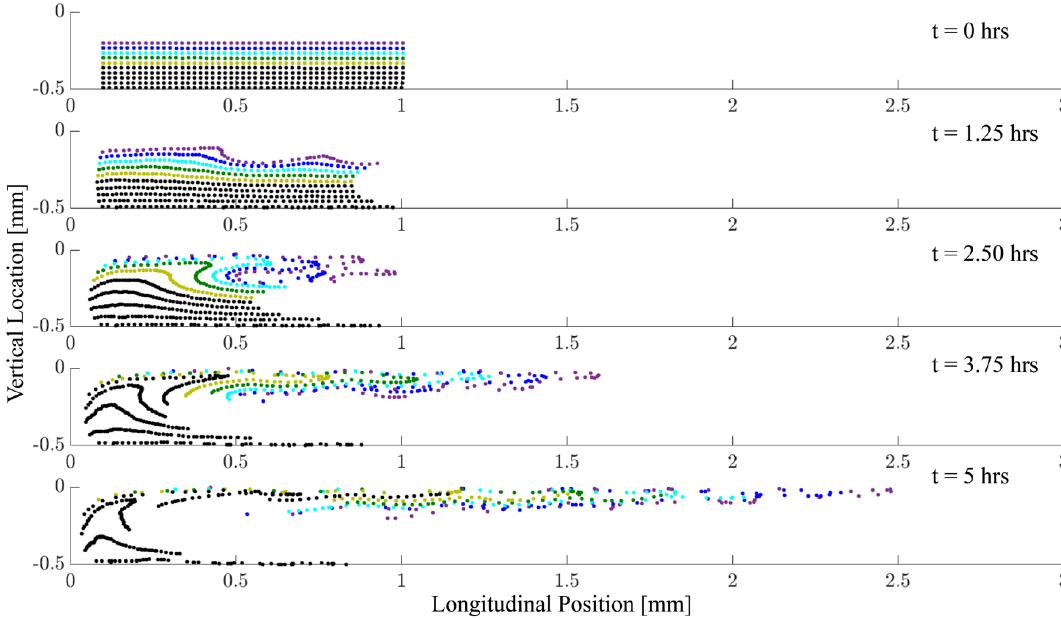
Figure 7. Individual particles near the cochlear base (coloured dots) are displaced throughout the cochlea due to steady streaming. We show the particle displacement in the bottom channel as induced by multi-frequency 330 µ m . Particles near the membrane (purple) are stimulation at 80 dB SPL with a frequency separation of δ = quickly displaced towards the base, while particles away from the membrane (black) are first moved towards the membrane and then towards the apex.